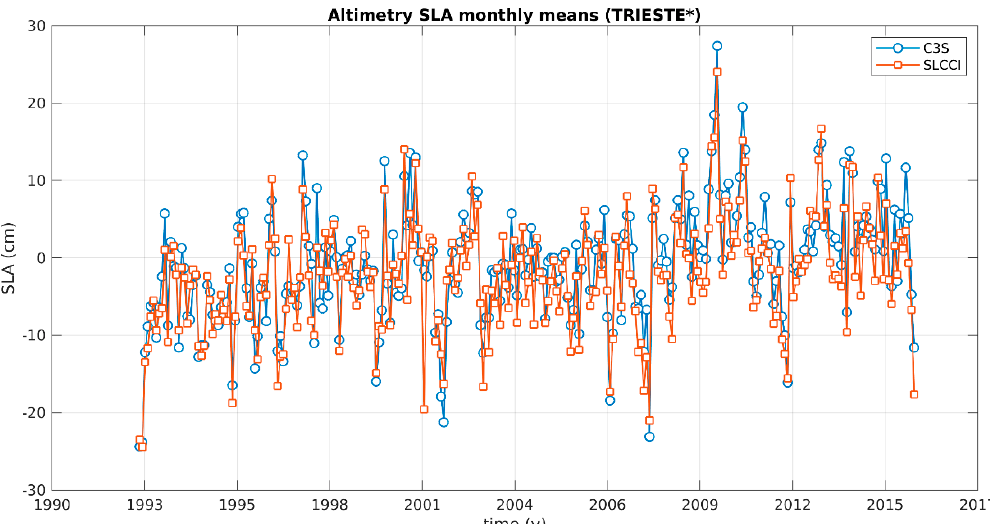
Figure 2. Two sea level anomaly (SLA) monthly mean altimetric time series at the most correlated altimetry grid point near Trieste. Cyan: Copernicus Climate Change Service (C3S); orange: Sea Level Climate Change Initiative (SLCCI). The general trend is similar, but differences are visible, and globally SLCCI seems to increase more gently than C3S. Linear correlation with tide gauge (TG) time series of relative sea-level change is similar for both: 0.89 for SLCCI, 0.90 for C3S.